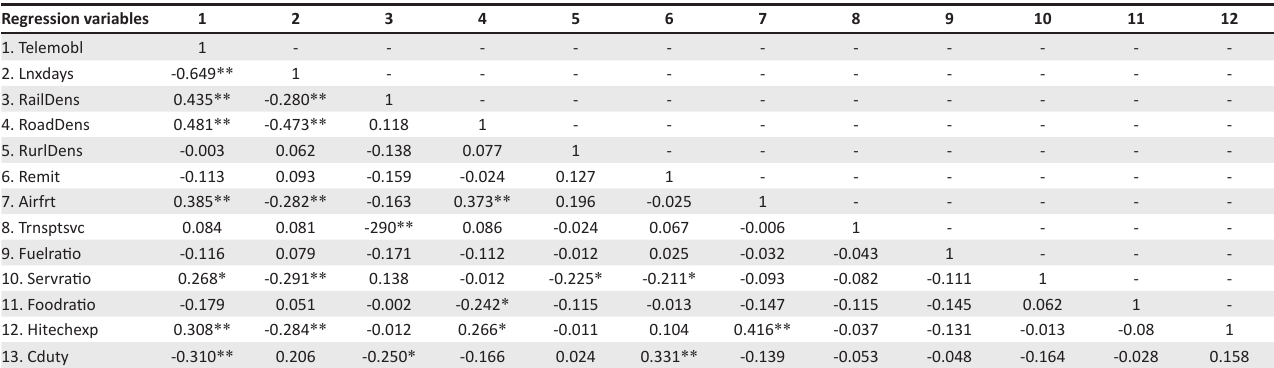
TABLE 2: Correlation matrix. Regression